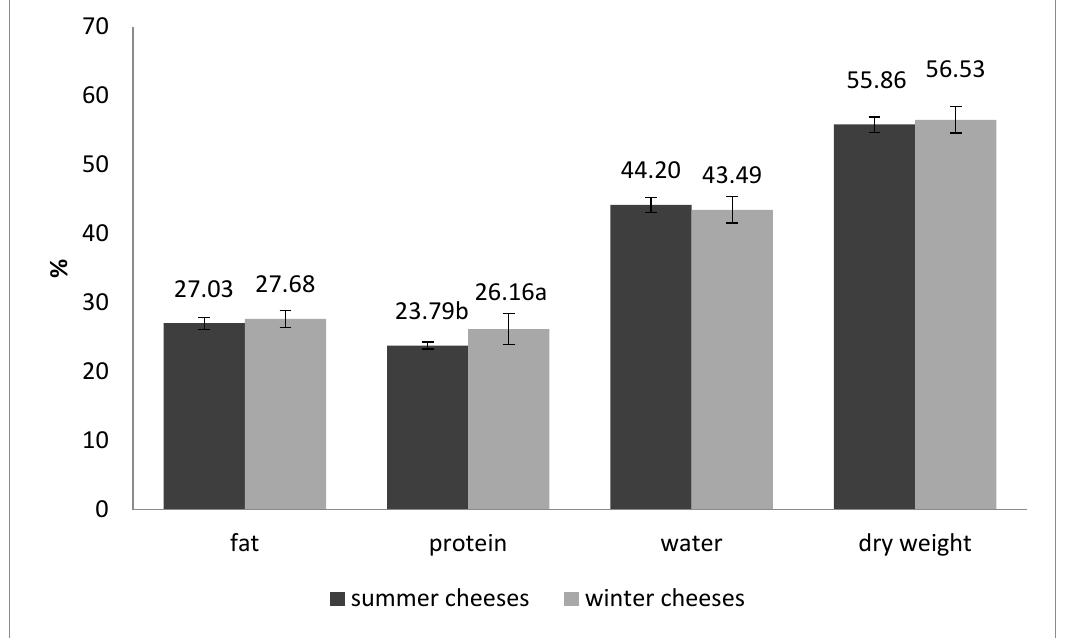
Figure 1. The chemical composition (%) of summer and winter cheeses made from cow’s milk. a,b—values differ significantly between groups ( p < 0.05).